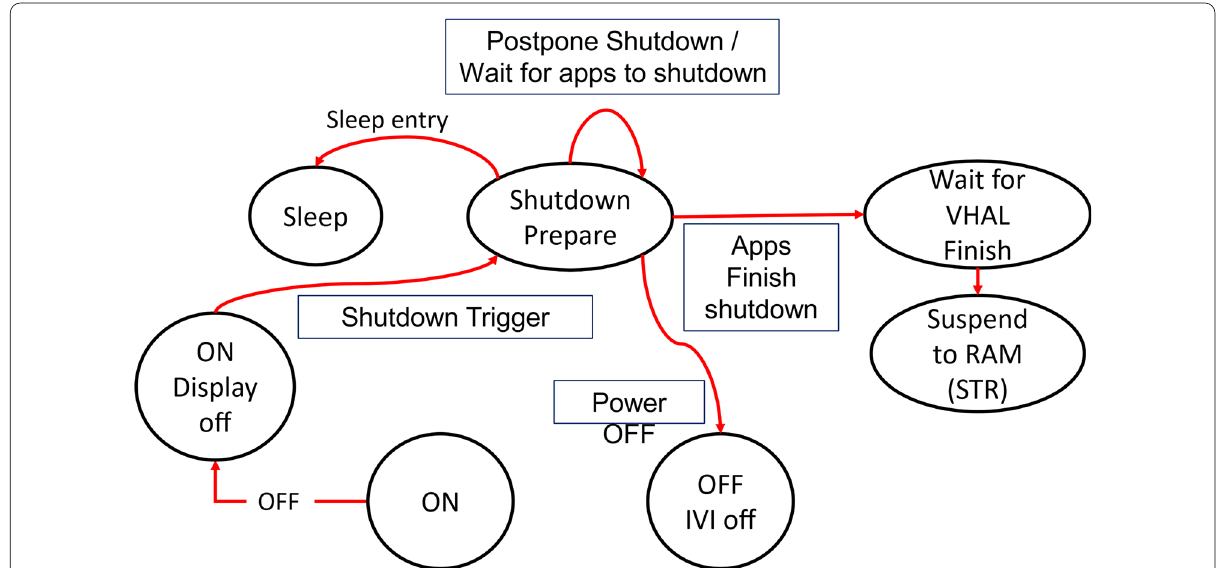
Fig. 3 Car power state machine. The states (ellipses) are triggered through